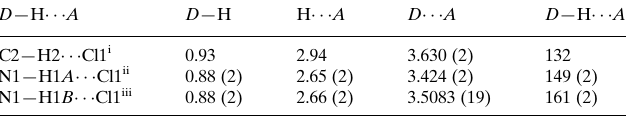
Hydrogen-bond geometry (A˚ , (cid:3)